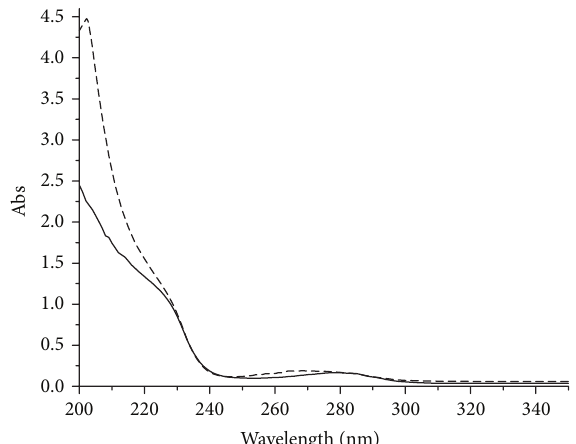
Figure 4: Different UV spectrum of GST-ZNF191(243-368) and GST. Solid line is UV spectrum of ZNF191(243-368) and dash line is different UV spectrum of GST-ZNF191(243-368) and GST.